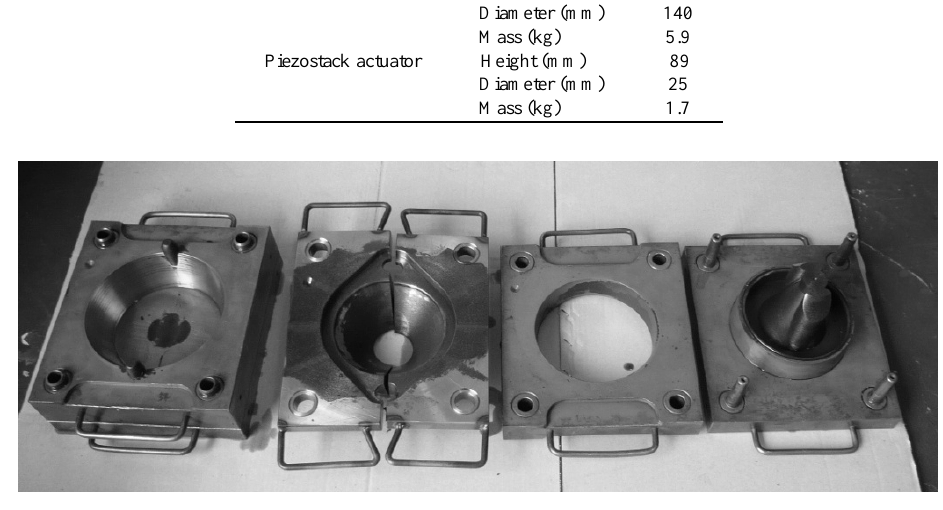
Fig. 4. Mold for the proposed hybrid mount.